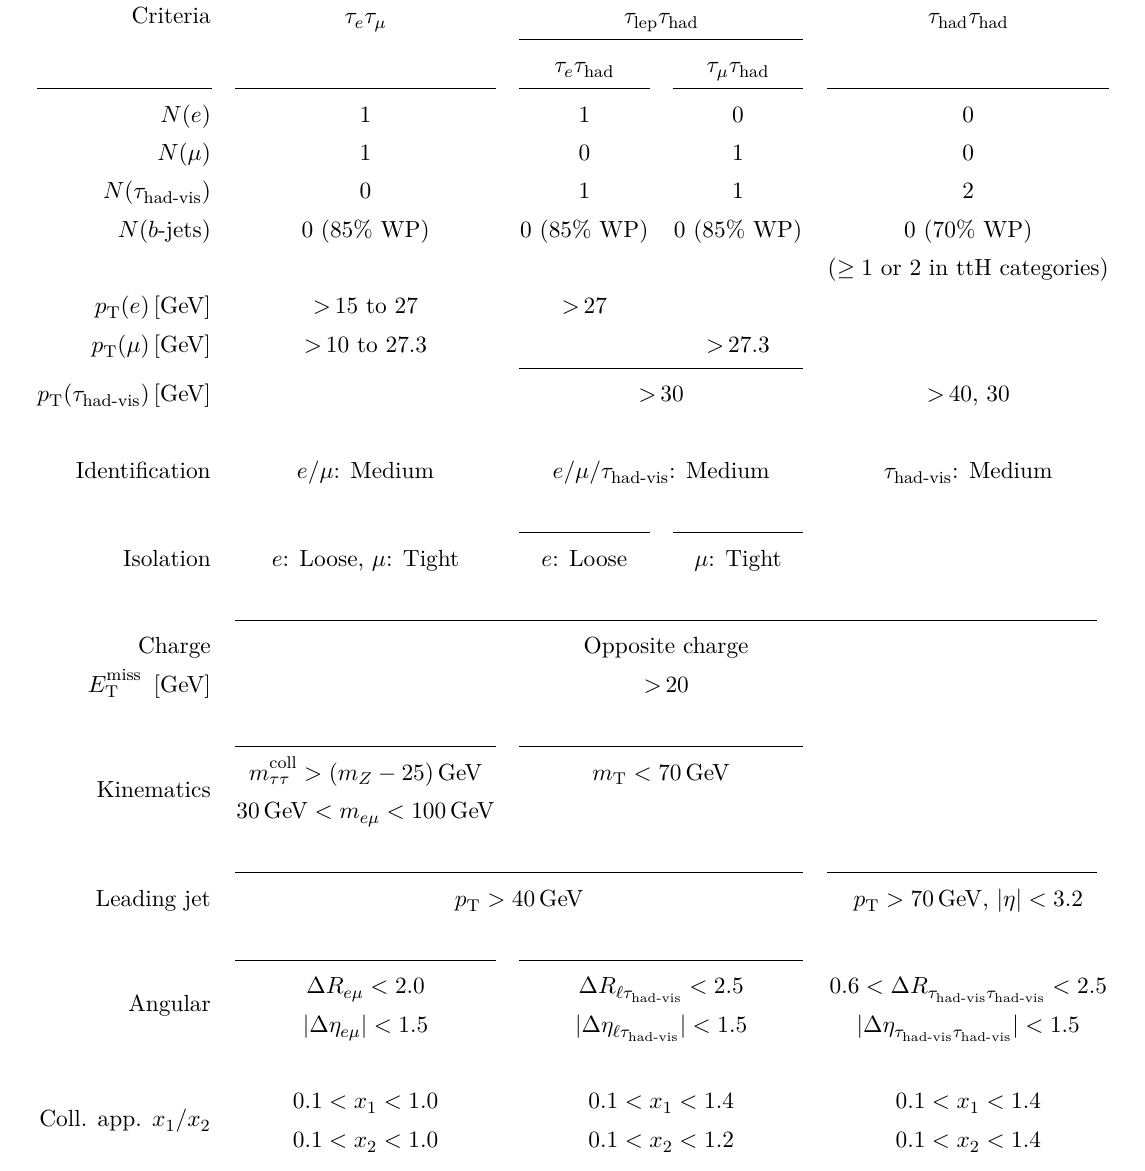
Table 4. Summary of the event selection for all sub-channels. The electron and muon p correspond to the 2016–2018 dataset. In the τ τ channel, events recorded with the electron trigger e µ must satisfy p ( e ) > 27 GeV and p ( µ ) > 10 GeV, events recorded with the muon trigger must T T satisfy p ( e ) > 15 GeV and p ( µ ) > 27 . 3 GeV, and events recorded with the electron-muon trigger T T table 2. The b -veto requirement in the τ τ channel is not applied in the tt(0 ‘ ) H → τ had had category. The quantities x and x are the momentum fractions carried by the visible decay products 1 2 of the two τ -leptons in the collinear approximation, as described in the